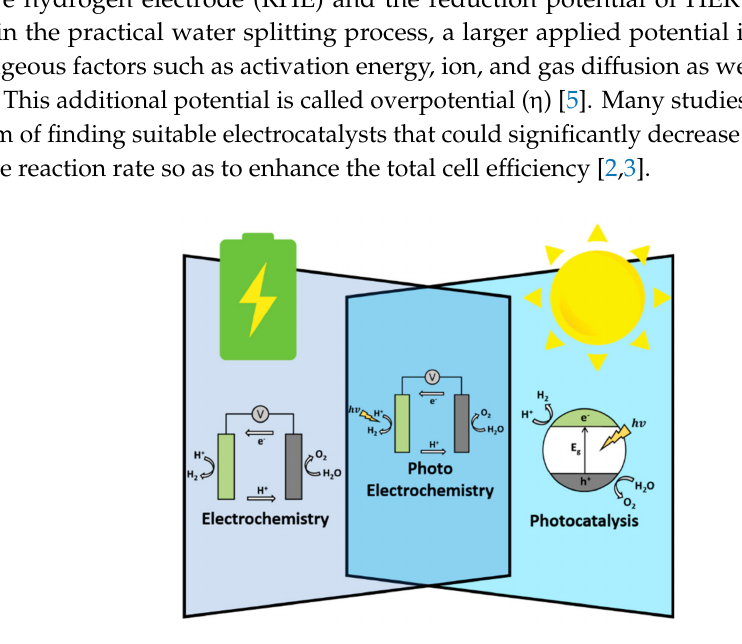
Figure 1. Schematic illustration of the three water splitting